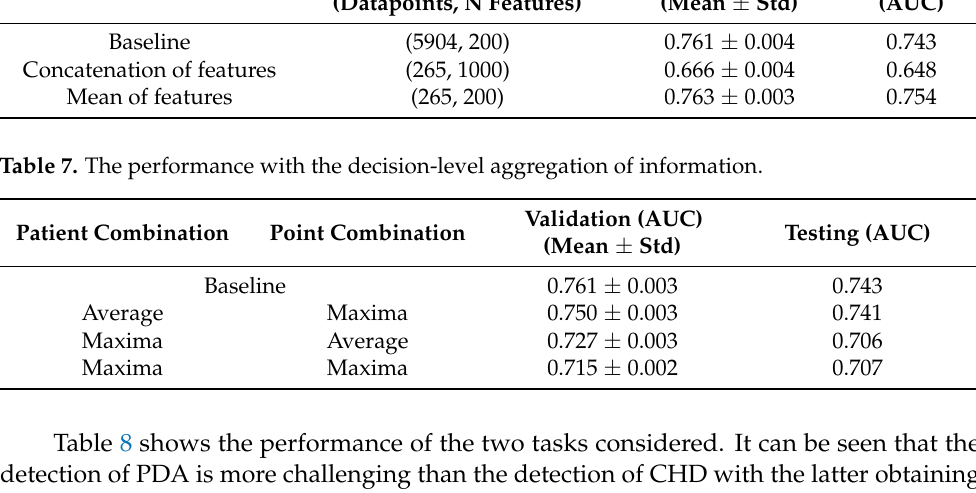
Table 6. The performance with the feature-level aggregation of information. Feature Transformation